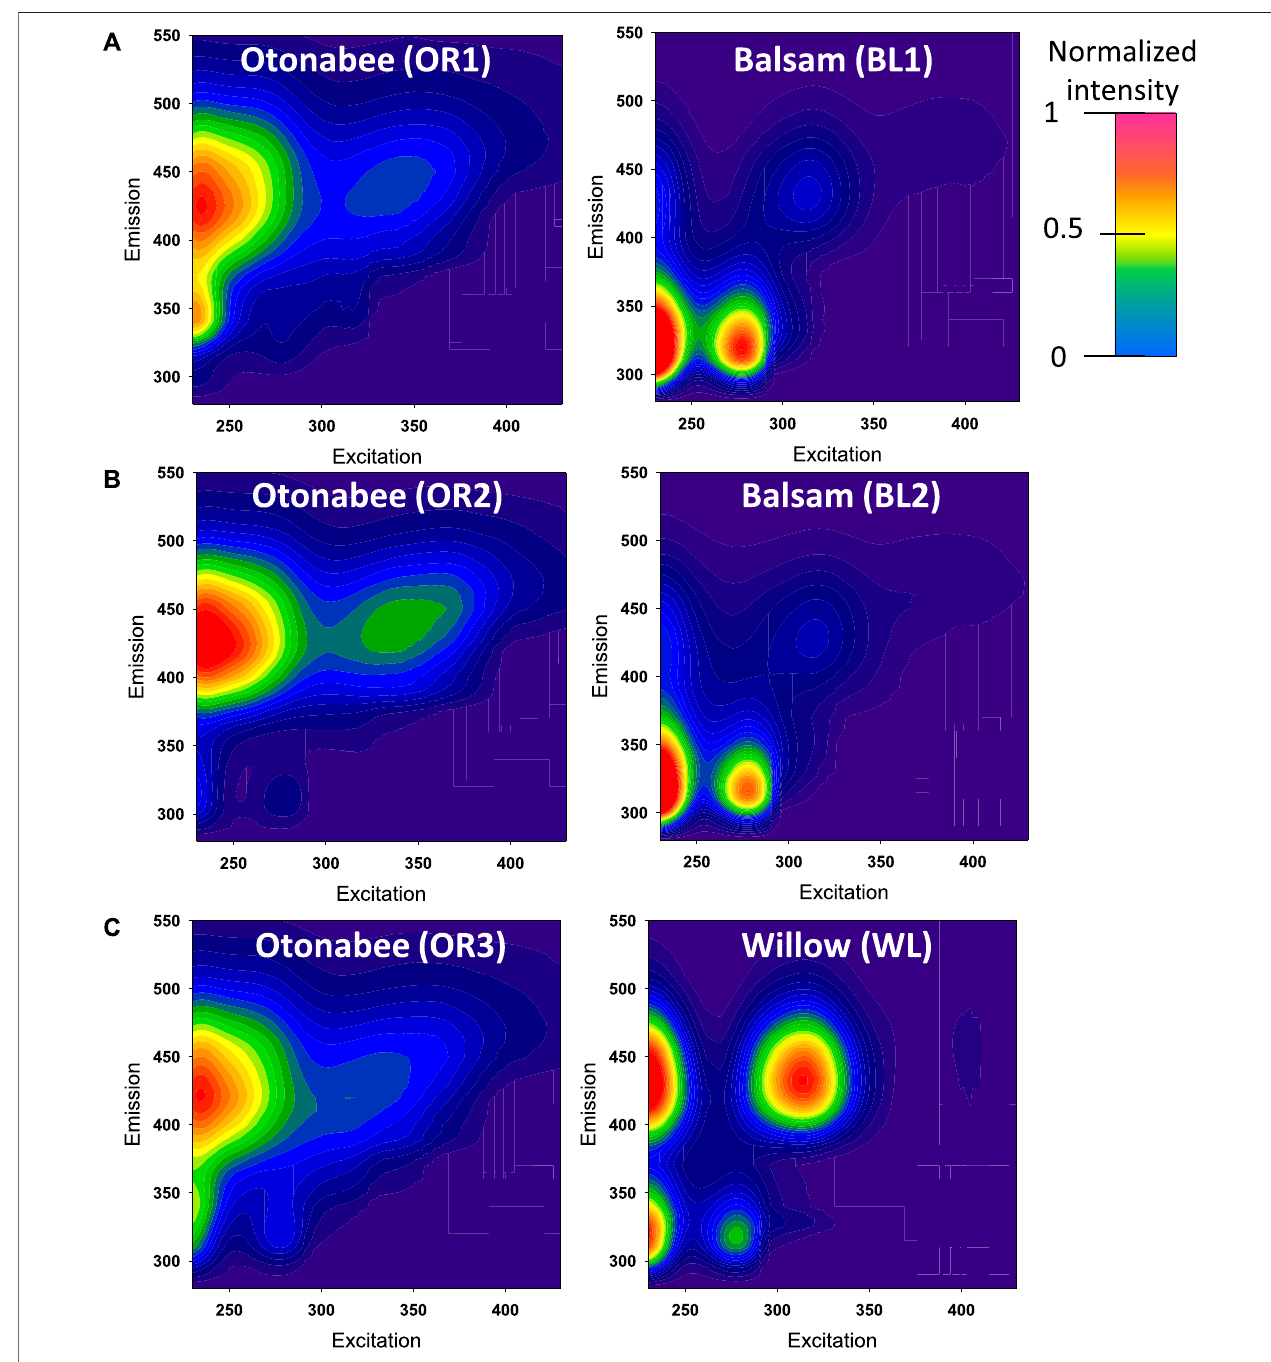
FIGURE 4 | Average PARAFAC-modeled EEMs for mixing end members from mixtures 1 to 3 (A – C) , respectively.